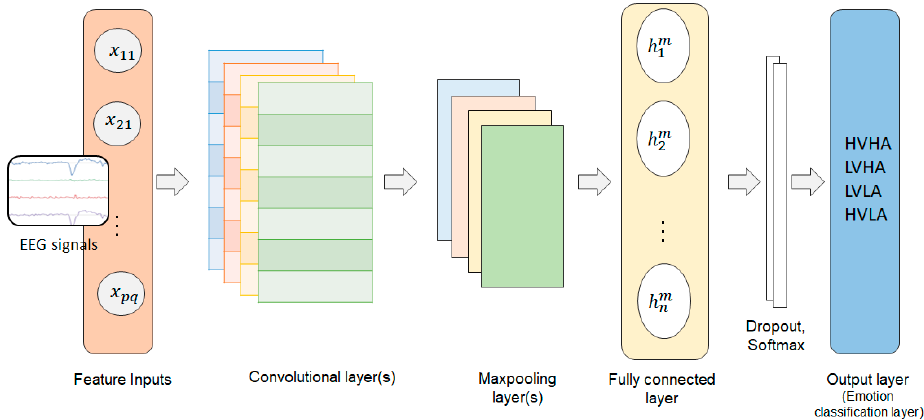
Figure 5. Block diagram of a convolutional neural network.